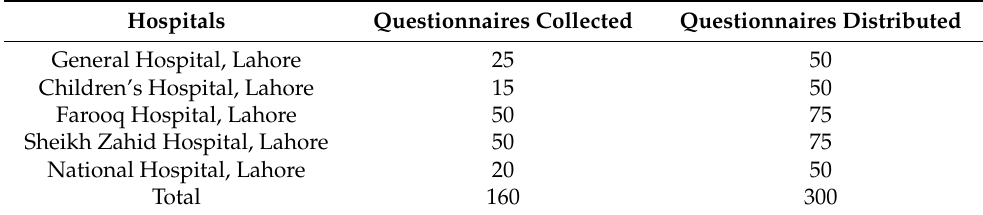
Table 2. References of questionnaire distributed and collected.